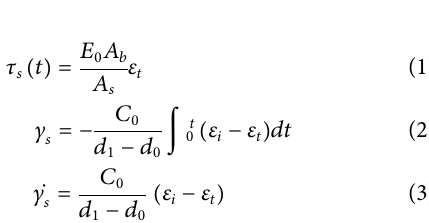
Frontiers in Materials |